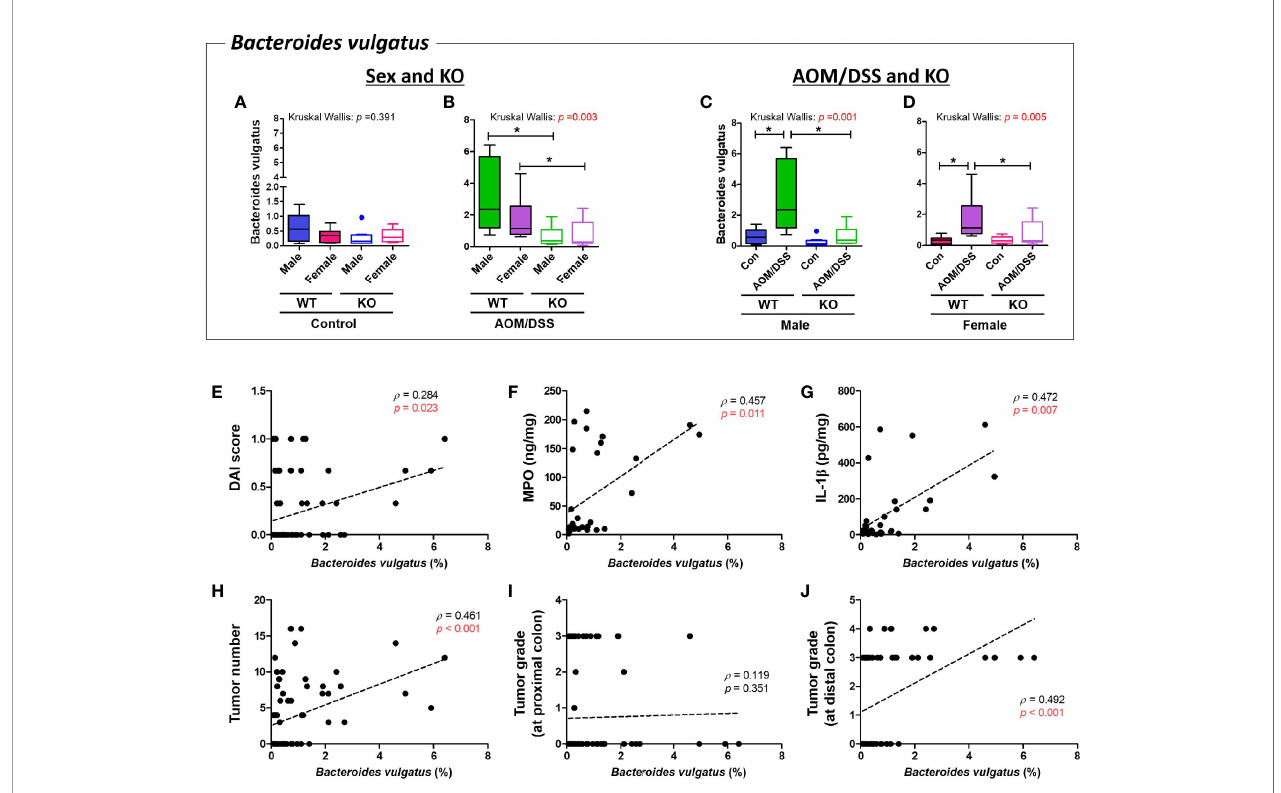
FIGURE 9 | Positive correlation between Bacteroides vulgatus and colitis-associated CRC indices. (A – D) Abundance (%) of Bacteroides vulgatus in the groups with “ Sex and KO ” criteria (A, B) , as well as with “ AOM/DSS and KO ” criteria (C, D) . Data are expressed as the mean ± SEM. Whiskers show the minimum and maximum values. The p -values calculated from the Kruskal – Wallis test are shown in the fi gure; * p < 0.05, comparison between two groups (Mann – Whitney U-test). CRC, colorectal cancer; WT, wild-type; KO, Nrf2 knockout; Con, control; AOM, azoxymethane; DSS, dextran sodium sulfate; SEM, standard error of mean. (E-J) The abundance of Bacteroides vulgatus was signi fi cantly correlated with tumor indices. (E) DAI score, (F) MPO concentration, (G) IL-1 b concentration, (H) total tumor numbers, (I) grade of tumor arising from the proximal colon, and (J) grade of tumor arising from the distal colon. p < 0.05 obtained from Spearman ’ s correlation analysis (E – J) . Dotted line indicates the regression line. The correlations were analyzed using Spearman ’ s rank correlation coef fi cient (also known as Spearman ’ s rho) and linear regression. DAI, disease activity index; MPO, myeloperoxidase. Tumor grade: 0, no tumor; 1, low-grade adenoma; 2, high-grade adenoma; 3, mucosal invasive adenocarcinoma; 4, submucosal invasive ( Supplementary Figure S7G ). E1 of the female group with “